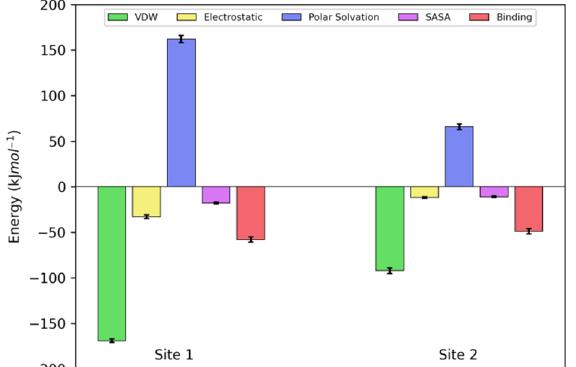
Figure 11. Energy decomposition obtained by MMPBSA for the interactions of NBD with PPL for Site 1 and 2. Contributions of Van der Waals (VDW), electrostatic, polar solvation (P.Solvation), and solvent accessible area (SASA) to the final binding energy (Binding).